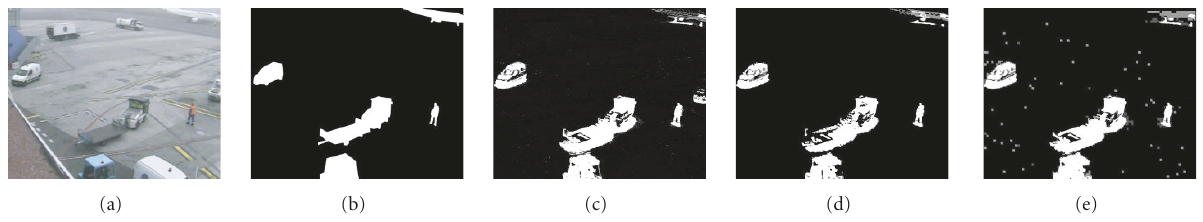
Figure 11: (Clockwise from top-left) the manually created ground truth and the detection results for the CEF, MoG, and CMV algorithms for frame 5814 taken from Dataset S21-Camera 7. The apparent increased noise (grey blocks, representing highlights and/or shadow) in the CMV result is due to the multiresolution implementation of this background subtraction